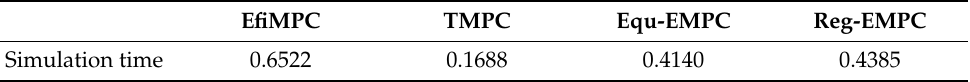
Table 2. The online computation times of the comparative control strategies (seconds).